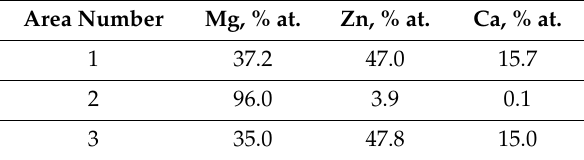
Table 3. The content of individual alloy components in a given area of Zn 87 Mg 9 Ca 4 alloy. Area Number Mg, % at.